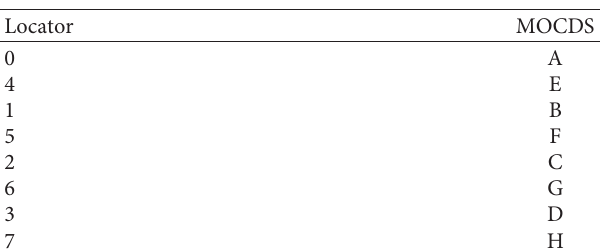
Table 2: Minimum outer-convex dominating sets of G , where n � 1. Locator